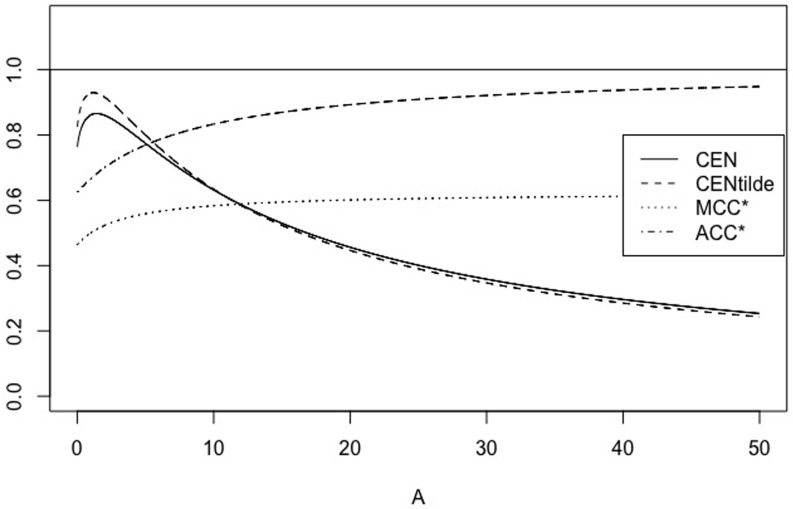
Family ZA.CEN, MCEN, MCC* and ACC* as function of A > 0 for N = 3.